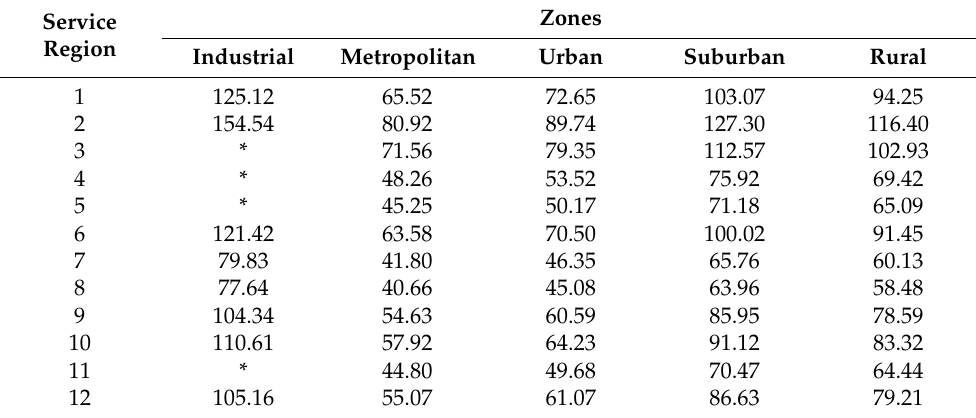
Table 4 (Exchange rate: THB 1 = USD 0.028). Table 4. Interruption energy rate of customers in different zones of each service